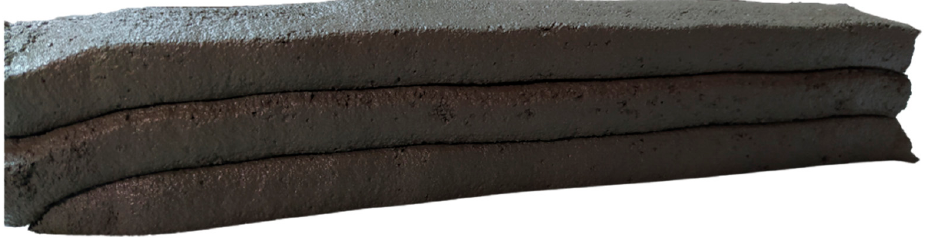
Figure 5. Typical appearance of freshly printed mortar beams.